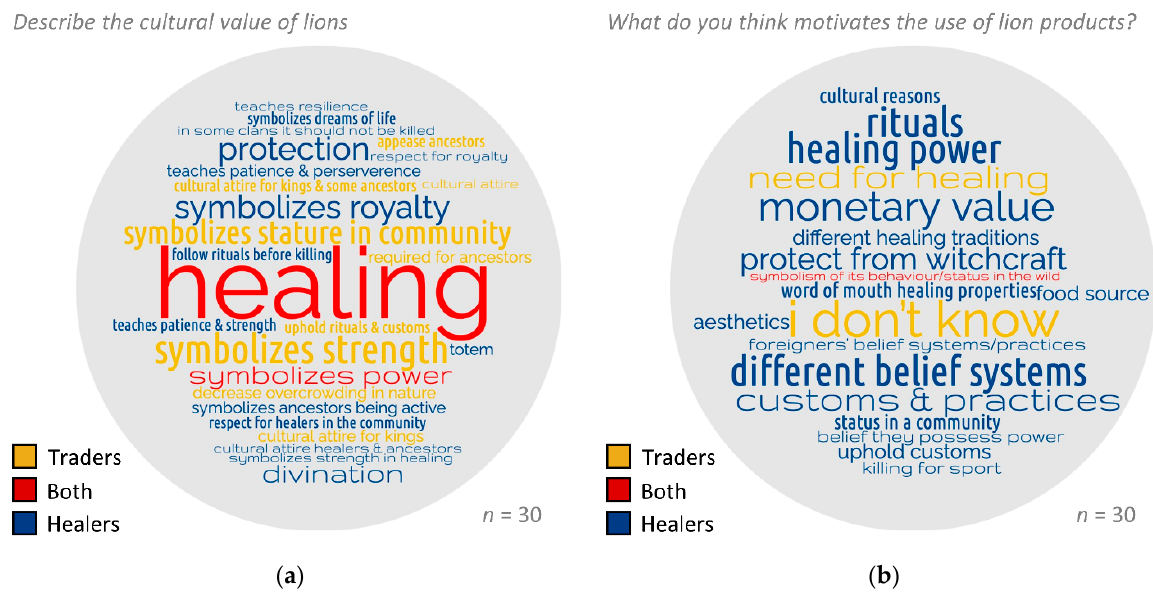
Figure 2. Significance and symbolism of lions and lion products from a survey ( n = 30) of traditional muthi traders ( n = 10) and healers ( n = 20) in South Africa between August and September 2019. Responses are divided into those from traders only (yellow), both traders and healers (red), and healers only (blue). ( a ) A word cloud of descriptions for the cultural value of lions; ( b ) A word cloud of what is believed to motivate the use of lion products.